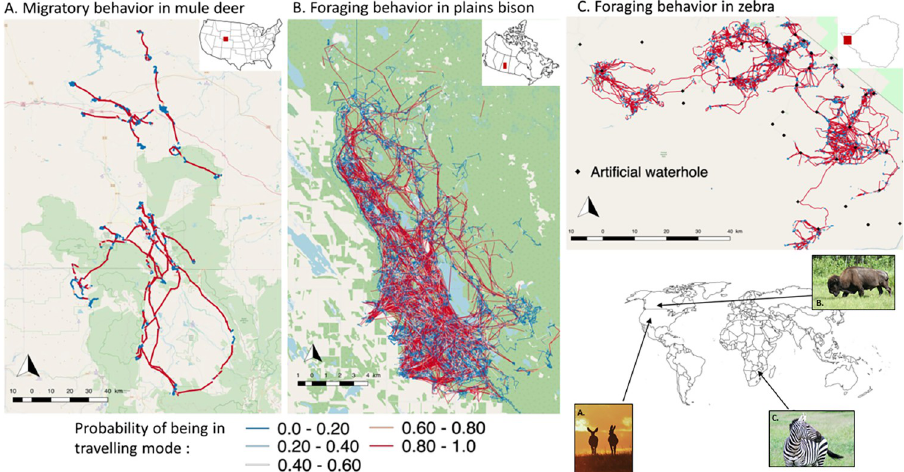
Fig 1. Trajectories of 42 plains bison geolocalised every hour between 2005 and 2016, during summer season in Prince Albert National Park (SK, Canada), 15 mule deer geolocalised every 3 hours during 2012 spring migration in and around Medicine Bow National Forest (WY-CO, USA) and 17 zebras geolocalised every half hour between 2012 and 2014, during dry hot season in Hwange National Park (Zimbabwe). The conditional probability of being in travelling mode of movement at each step, estimated from the HMM-SSF, is represented using a blue (low) to red (high) gradient.